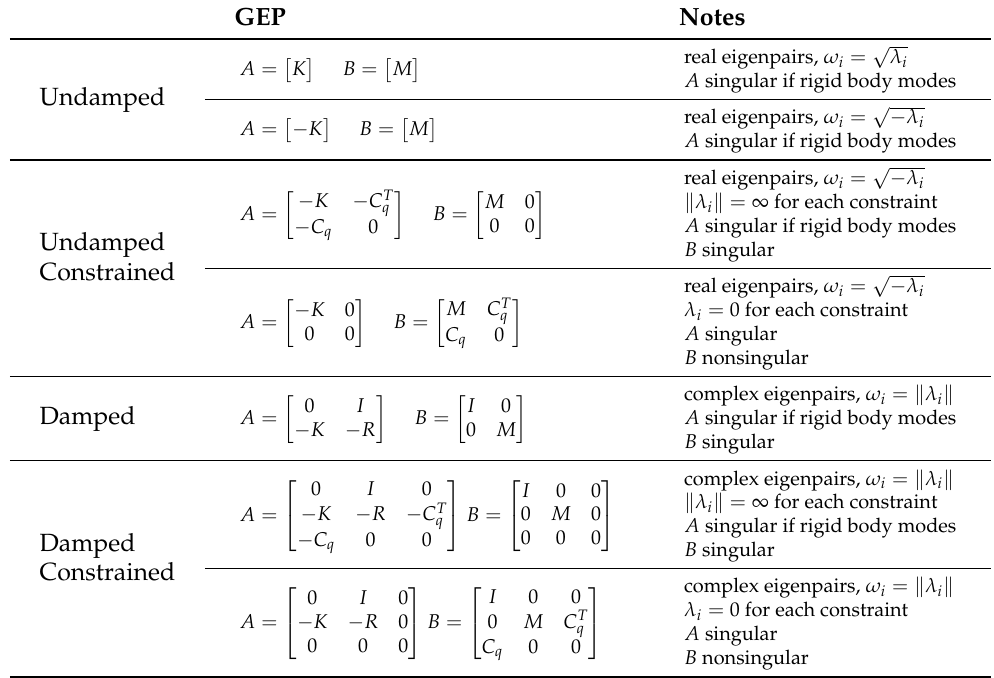
Table 1. Different options for the eigenpair